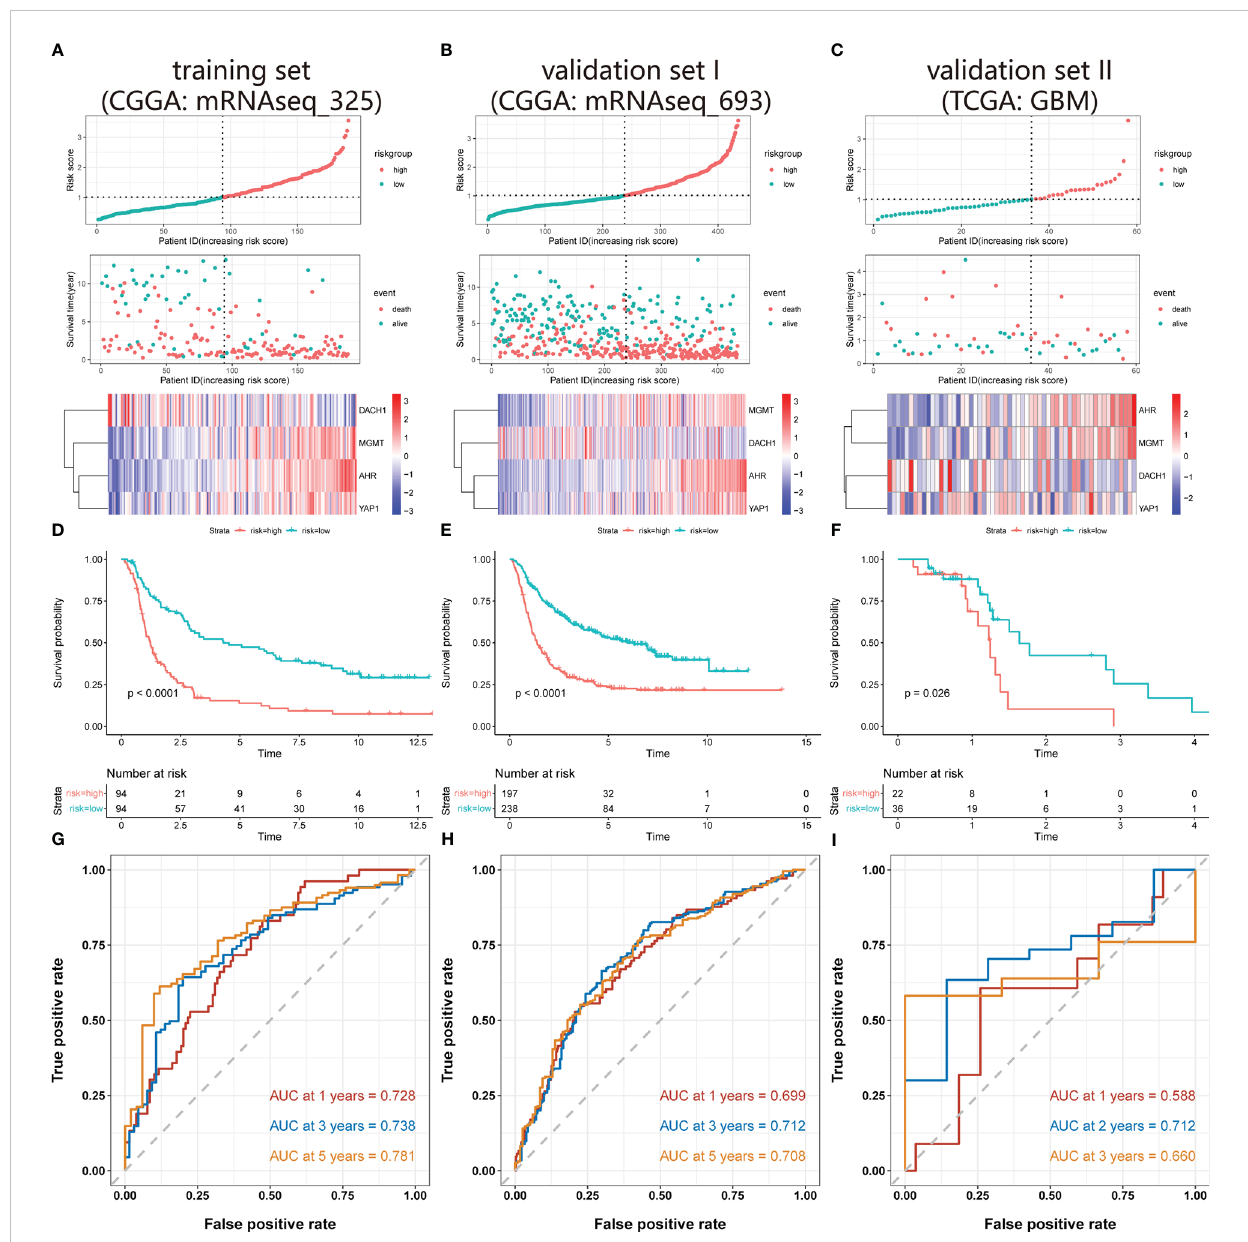
FIGURE 3 Validation of the risk model. (A-C) The top 3 panels show the proportional relationship between the high-risk and low-risk groups. Patients are ranked according to their riskScore from low to high, and the dotted line divides patients into high-risk group (indicated by red dots) and low-risk group (indicated by green dots). The middle 3 panels show the relationship between the riskScore and patient survival time (red dots indicate dead patients, green dots indicate alive patients). As the riskScore increases, the survival time of patients decreases and the number of deaths increases. The bottom 3 panels show the relationship between the riskScore and the expression level of the feature genes. As the riskScore increases, the expression of MGMT, AHR, and YAP1 increases, while the expression of DACH1 decreases. (D-F) The red represents the high-risk group, and the green represents the low-risk group. Patients ’ survival rates in the high-risk group were signi fi cantly lower than in the low-risk group (P<O.O5). (G – I) ROC curves and AUC values at different time points. The red, blue, and orange lines in Figures A and B indicate the ROC curves for 1, 3, and 5 years, and in Figure C, the ROC curves for 1, 2, and 3 years. The AUC values are 0.728, 0.738, and 0.781 in the CGGA-mRNAseq_325, 0.699, 0.712, and 0.708 in the CGGA-mRNAseq_693, 0.588, 0.712, and 0.66 in the